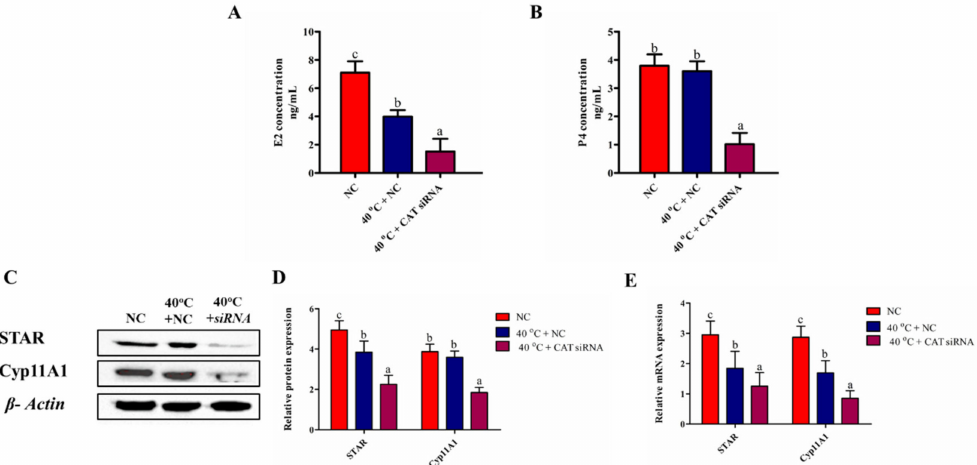
Figure 8. CAT regulates P4 and E2 synthesis in GCs under HS. Concentration of P4 and E2 in the culture medium released by the GCs in the di ff erent treated groups (40 ◦ C + NC and 40 ◦ C + CAT si RNA) and corresponding NC group ( A , B ). Western blot results of STAR and Cyp11A1 ( C , D ). The mRNA expression of STAR and Cy11A1 by RT-qPCR ( E ). Values are expressed as mean ± SEM of n = 3. Superscripts (a, b, c) represent a significant ( p < 0.05) di ff